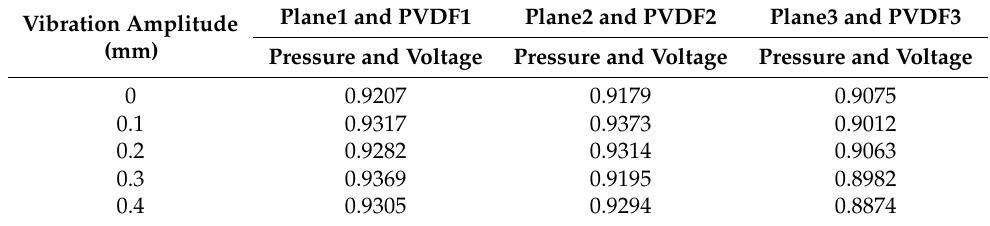
Table 10. Correlation coefficient.